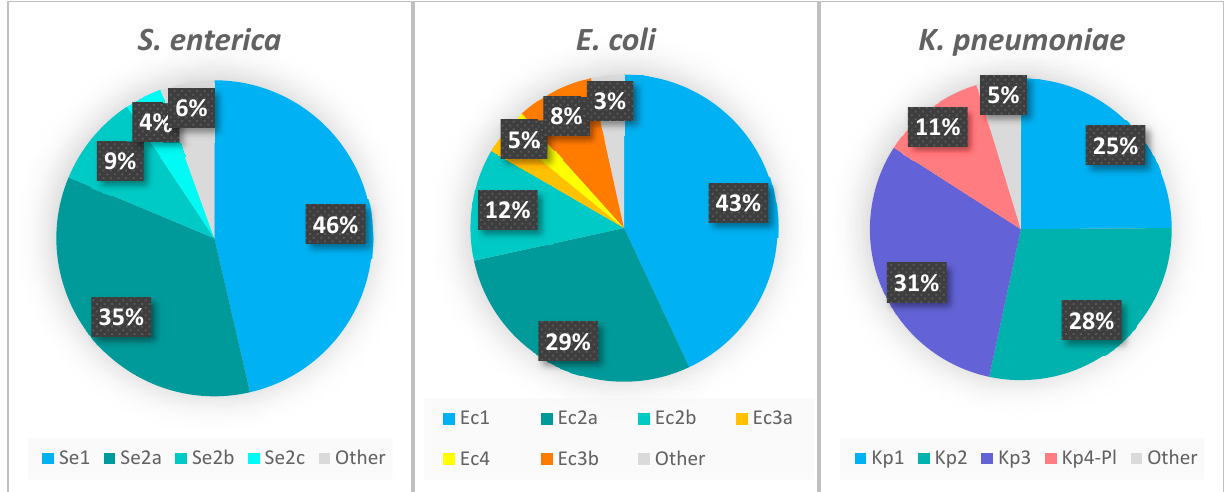
Figure 2. The proportion of CRISPR loci, regardless of the presence of the Cas-cluster. “Other” represents the CRISPR arrays that are not part of the main loci.